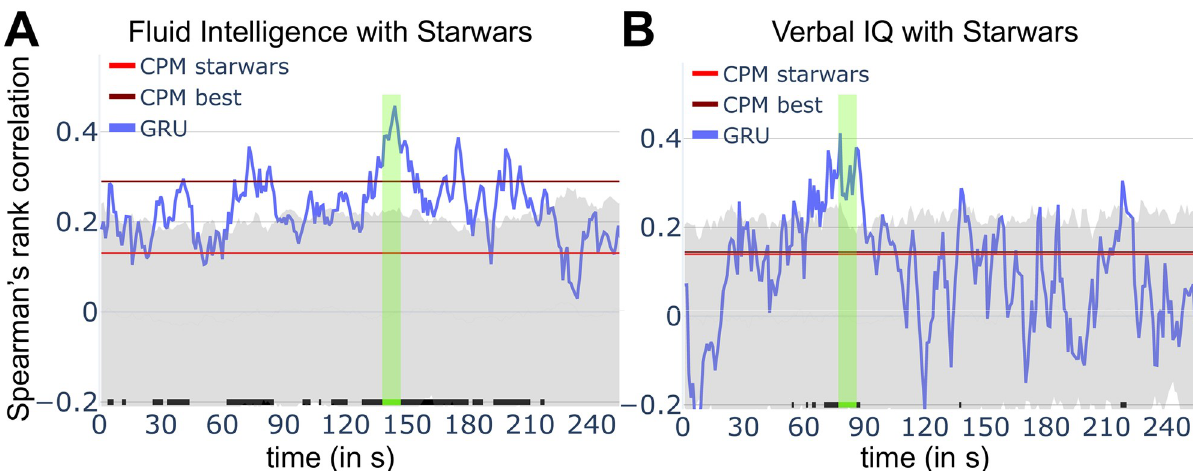
Fig 6. Prediction of behavior. (A) Prediction of fluid intelligence scores as a function of time. Prediction (blue) fluctuates considerably but consistently exceeds chance values (indicated by the tic marks at the bottom). Values obtained by connectome-based predictive modeling (CPM) are indicated for comparison (red: CPM applied to Star Wars data; maroon: highest value applying CPM across all clips). The gray region indicates the 95 th percentile region based on permutation testing (N.B.: applies to our method only, not CPM). (B) Prediction of verbal IQ as a function of time. Only short periods of time of the Star Wars clip exceeded chance levels. The green bar indicates a segment of the time series that is significant at the 0.05 level corrected for multiple comparisons.